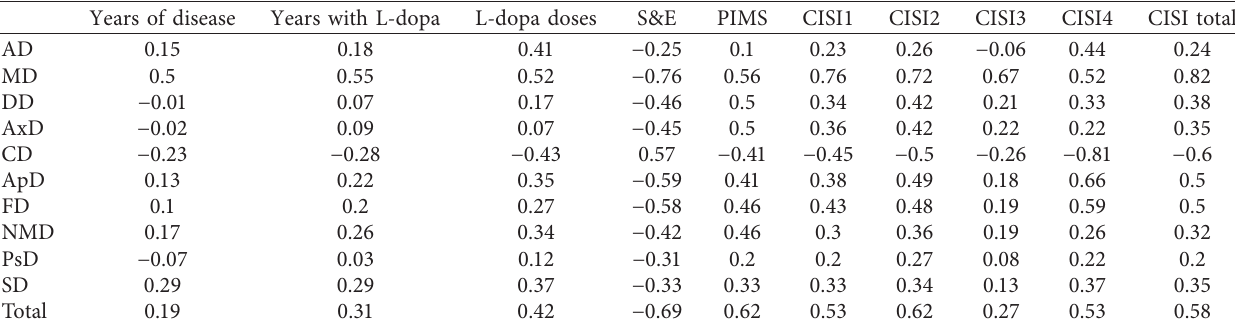
Table 6: Correlation between the Parkinson’s Disease Gravity Index and other measures.